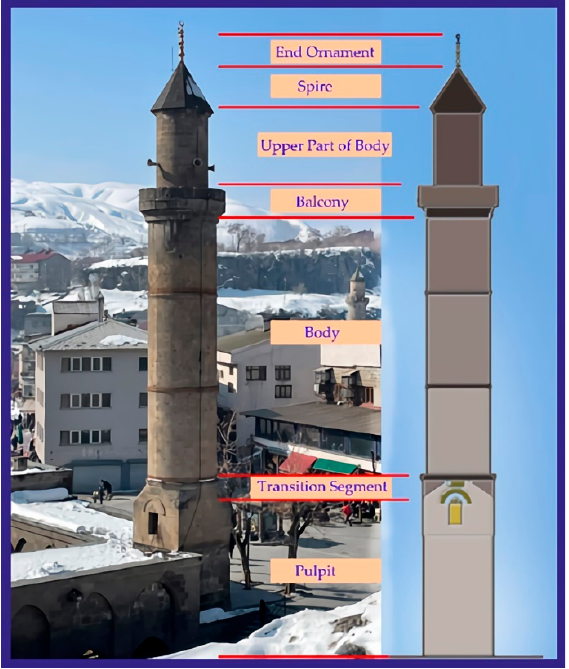
Figure 1. Bitlis Ulu Mosque’s minaret parts.